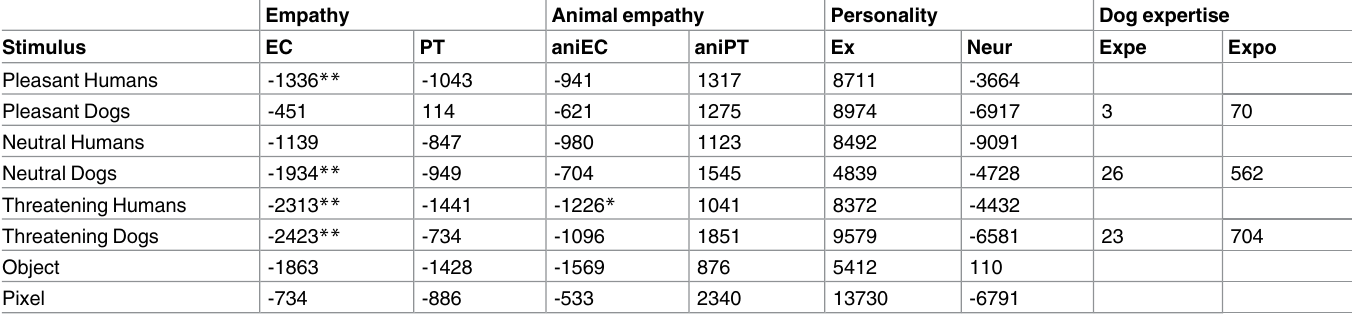
Table 4. Connections of psychological factors to the response times in rating stimulus valence. Responsetimes for valenceestimationwere tested with Emotional Concern(EC), Perspective-taking (PT), animal-directed EmotionalConcern(aniEC) and animal-directed Perspective-taking(aniPT), Extraver- sion (Ex) and Neuroticism (Neur). Connections of dog stimuli with dog experience were obtainedwith dog expertise(Expe) and dog exposure(Expo) mea- sures. Significantregression coefficients (beta values)are marked with asterisks ( * p < 0.05, ** p < 0.01, *** p < 0.001).